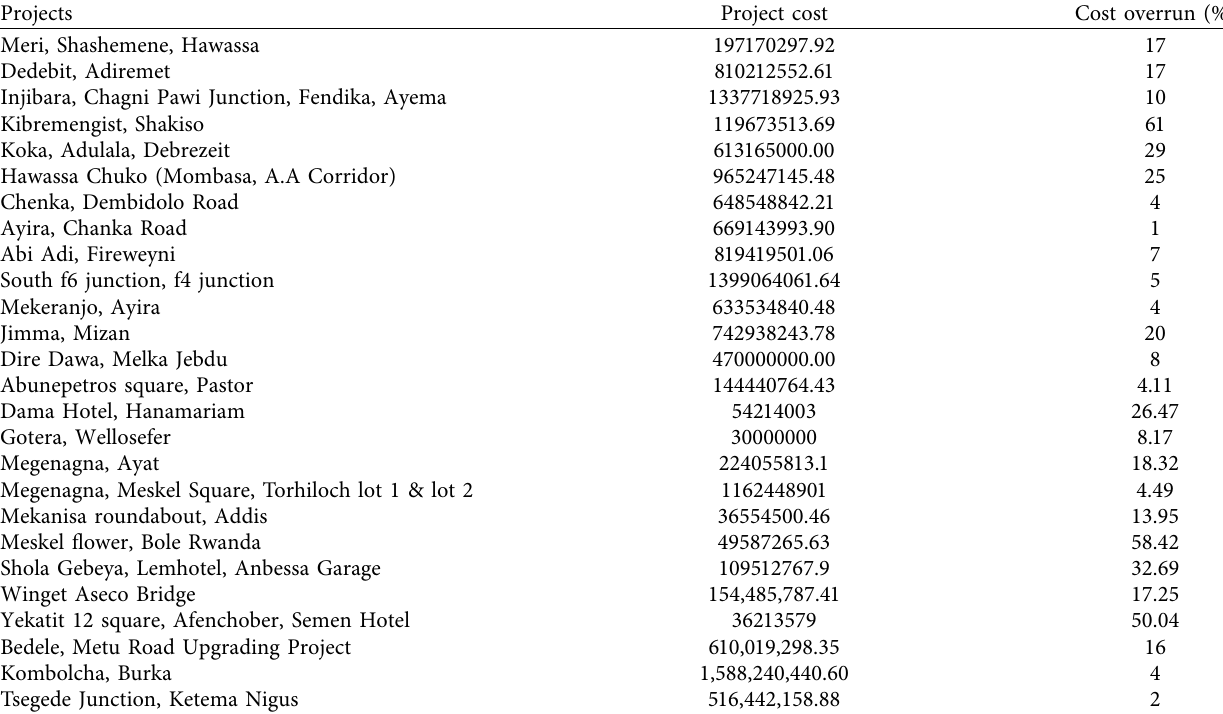
Table 4: Cost data for road projects in